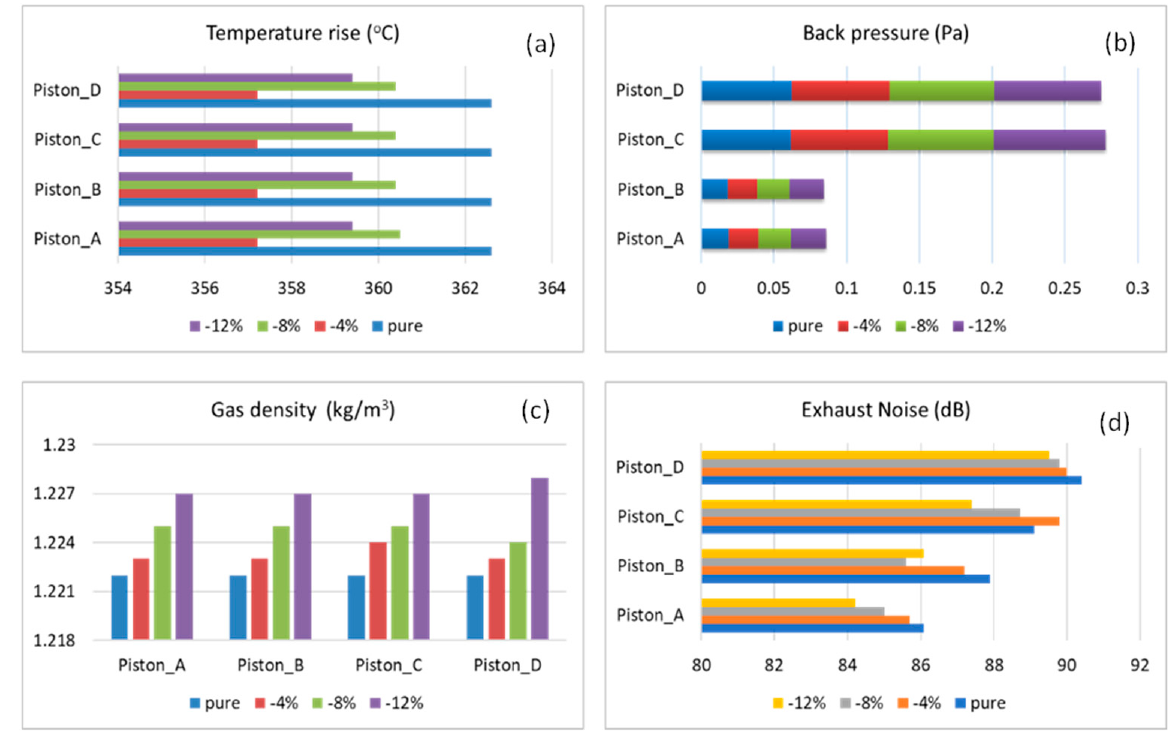
Figure 7. Bar chart of fuel carbon redundancy effect on energy influencing parameters: ( a ) temperature rise, ( b )back pressure variations, ( c )density variation, and ( d ) exhaust noise.